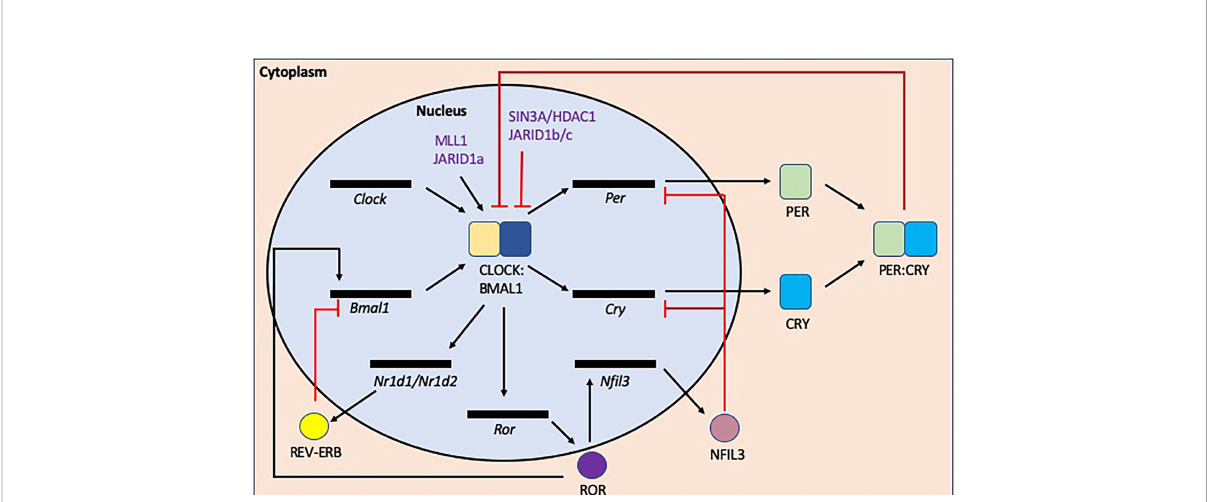
FIGURE 6 Transcription/translation feedback loops that modulate circadian rhythms at the molecular level. The induction of circadian rhythms relies on oscillations in gene expression and repression. In the initiation of the circadian rhythms, Bmal1 and Clock are transcribed/translated and then form a heterodimer. This CLOCK : BMAL1 heterodimer initiates the transcription of a number of genes including Per , Cry and Nr1d1/Nr1d2 ( rev- erb a / b ) genes, all which negatively repress the circadian initiators BMAL1 and/or CLOCK. In addition, CLOCK : BMAL1also activates Ror transcription, promoting transcription of Bmal1 , while also inducing N fi l3 transcription/translation, which inhibits Per and Cry gene transcription. There are also epigenetic modulation factors e.g. (de)acetylation or (de)methylation that also regulate the circadian rhythm as shown in